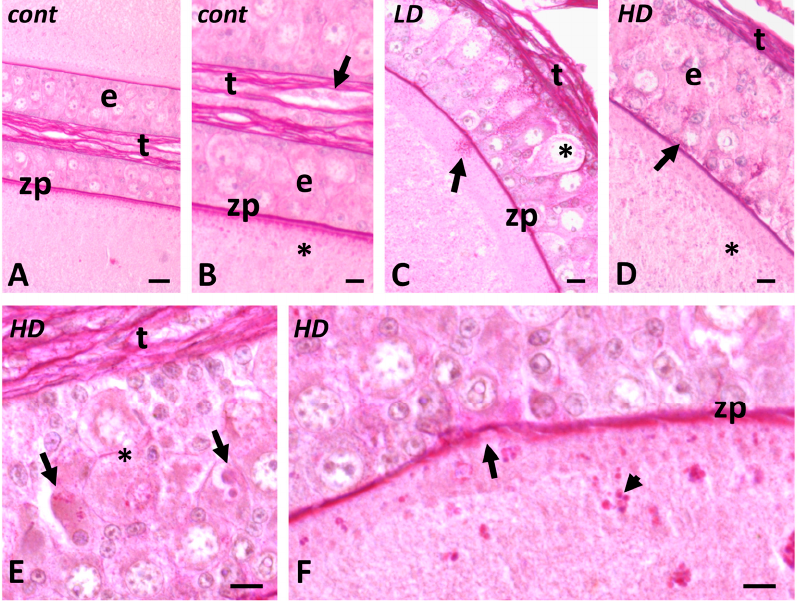
Figure 4. Effects of glyphosate (low LD and high HD doses) on carbohydrate distribution. PAS staining. ( A , B ) Stained zona pellucida (zp) and connective theca (t). Faintly stained epithelial cells (e) and oocyte cytoplasm (*). ( C ) Appearance of stained granules in follicle cells (arrow). Dense theca (t). ( D ) Release of PAS-positive granules (*) into the oocyte cytoplasm (arrow). Apoptotic cell (*). ( E ) Dense, poorly stained amorphic bodies (arrows); stained theca (t) and apoptotic pyriforms (*). ( F ) Disorganized zona pellucida (zp (arrow); PAS-positive granules (arrowhead) in the oocyte cortical cytoplasm. Scale bars: ( A ) 20 µ m; ( B – F ) 10 µ